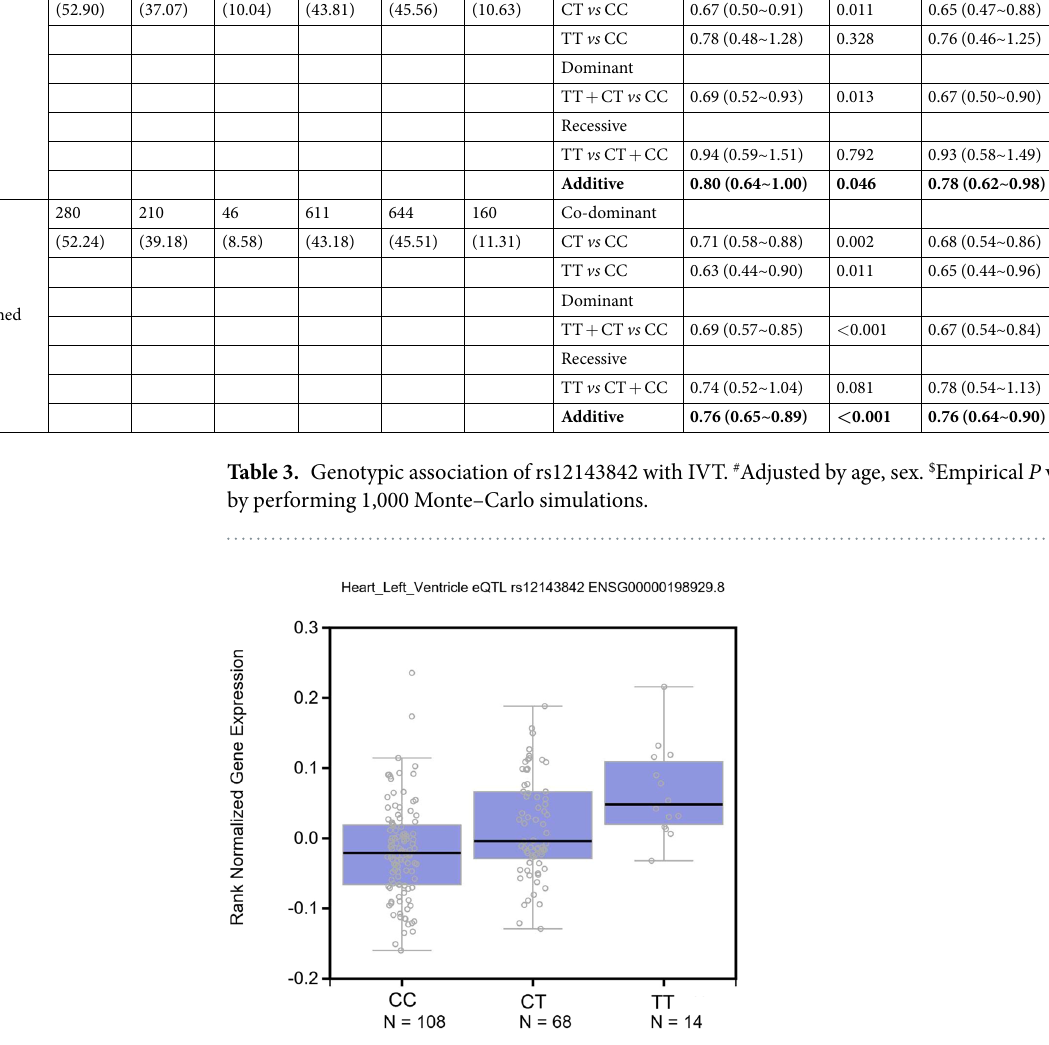
Figure 1. eQTL analysis using the GTEX database (www.gtexportal.org/). NOS1AP expression in the left ventricle was significantly higher with the rs12143842 T allele than the C allele ( P = 1.4 × 10 − 6 , Effect Size =